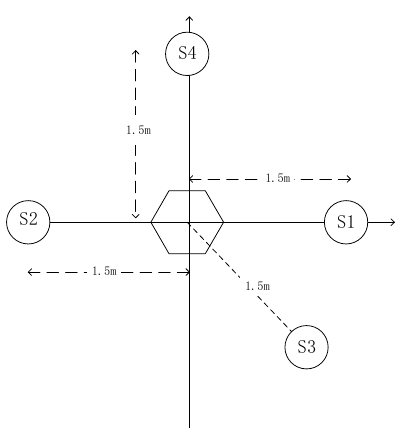
Figure 5. Distribution of sound sources to evaluate the proposed speech separation algorithm.